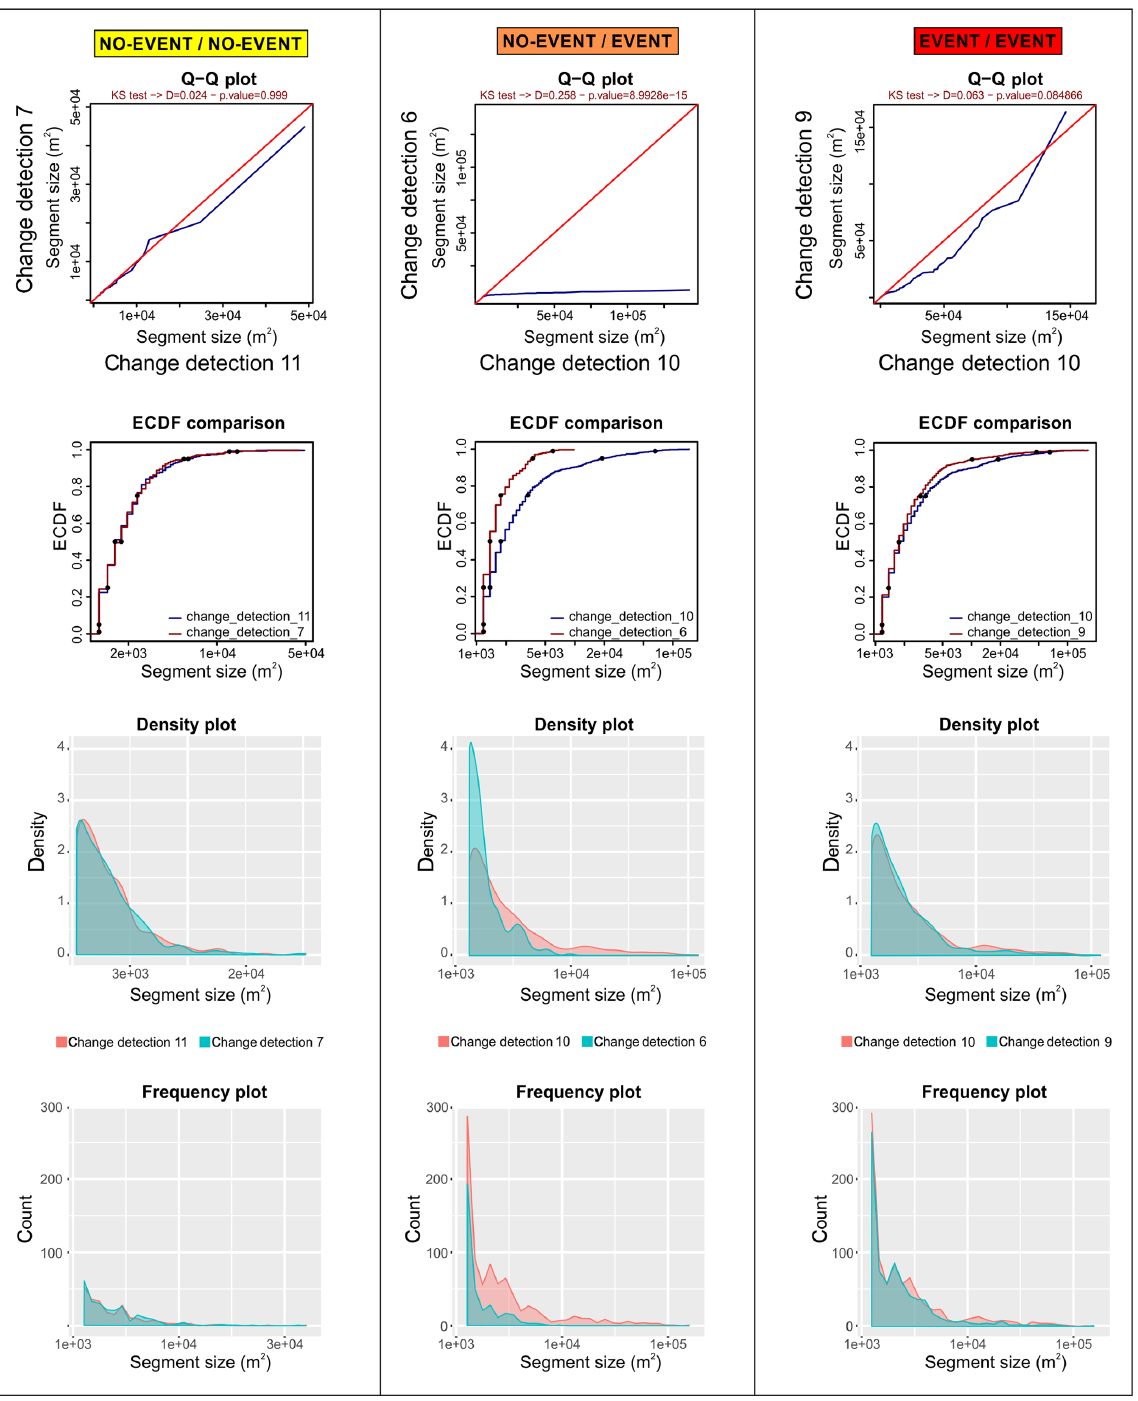
Figure 7. Comparison of segment’s area statistics related to different change